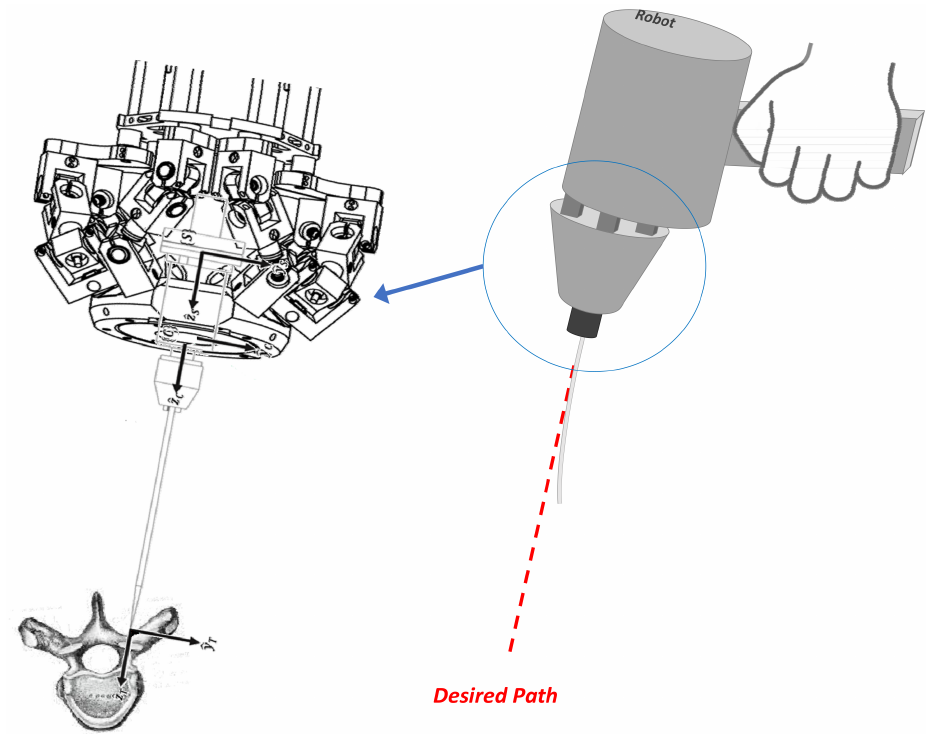
Figure 1. Schematic of a handheld robot with embedded force